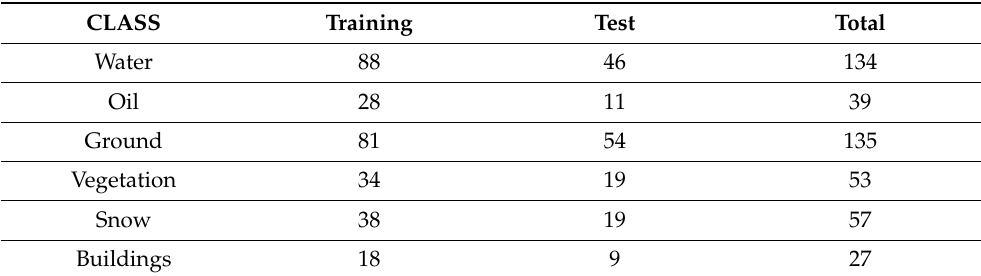
Figure 4. Segmentation Results. Table 1. Number of Training and Test